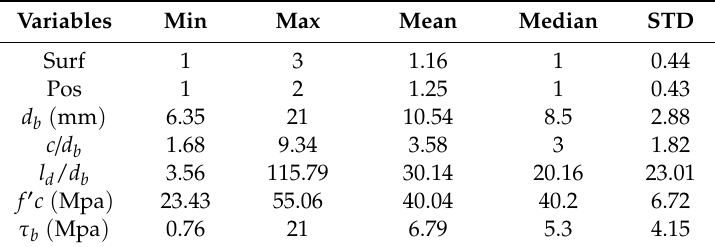
Table 1. Parameters involved in the model